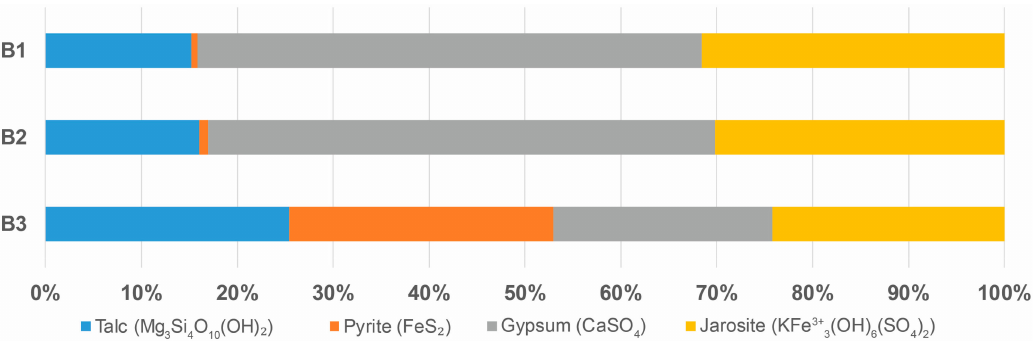
Figure 10. Bulk mineralogy (measured by XRD) of the residues collected at the end of the experiment from tanks B1, B2 and